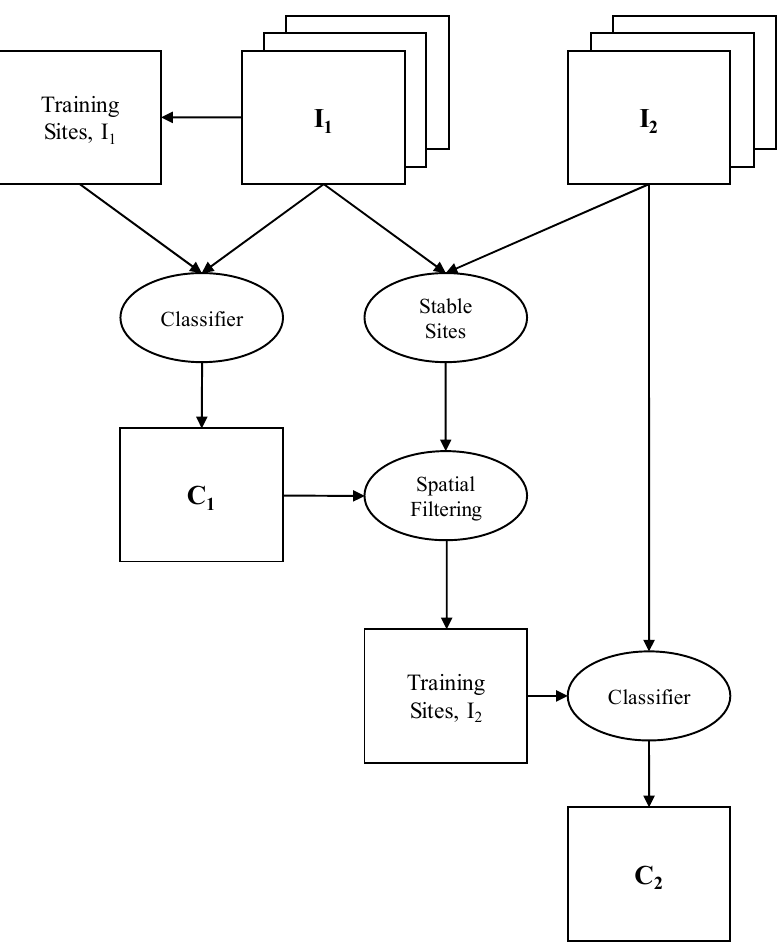
Figure 2. Workflow for the AASG method. Adapted from Gray and Song [17].